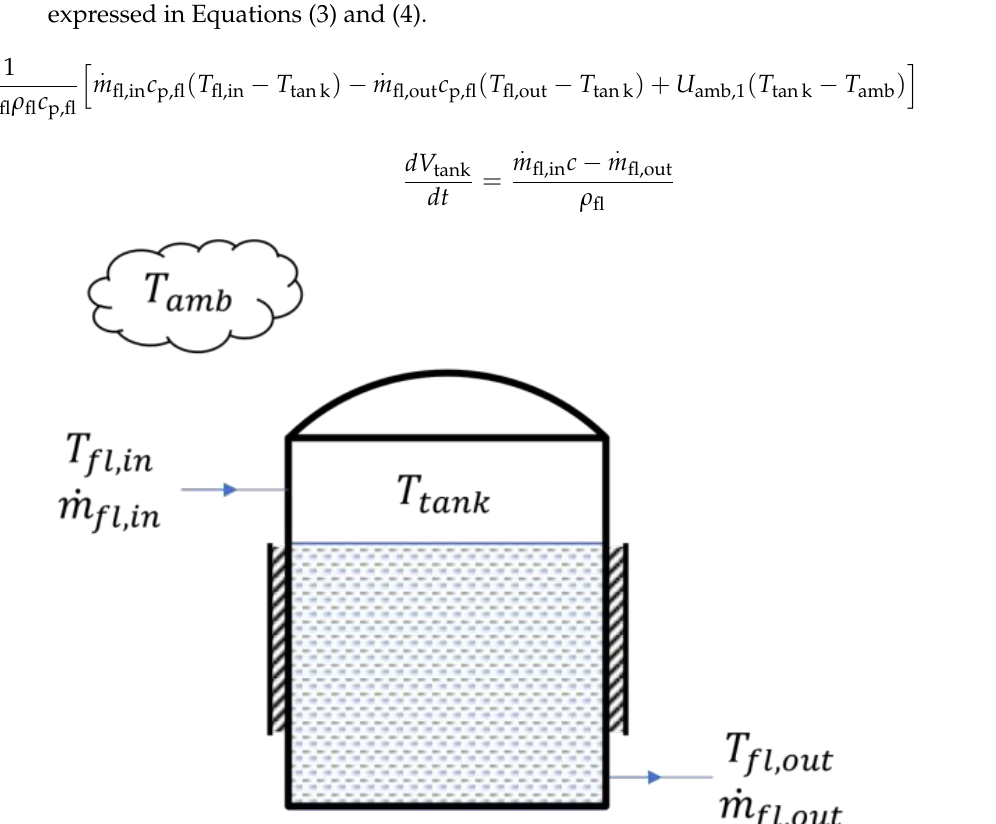
Figure 6. Each tank’s heat and mass transfer interaction in the lab-scale biohydrogen production system. Here, T tank is the temperature of the fluid inside the tank; V tank,fl is the volume of the fluid inside the tank; c p,fl is the specific heat capacity of the fluid inside the tank; . m fl,out are the mass flow rates at the inlet and outlet of the tank, respectively; T fl,in and T fl,out are the temperatures at the inlet and outlet of the tank, respectively; U amb,1 is the overall heat-transfer coefficient between the fluid inside the tank and the ambient air; and T amb is the ambient